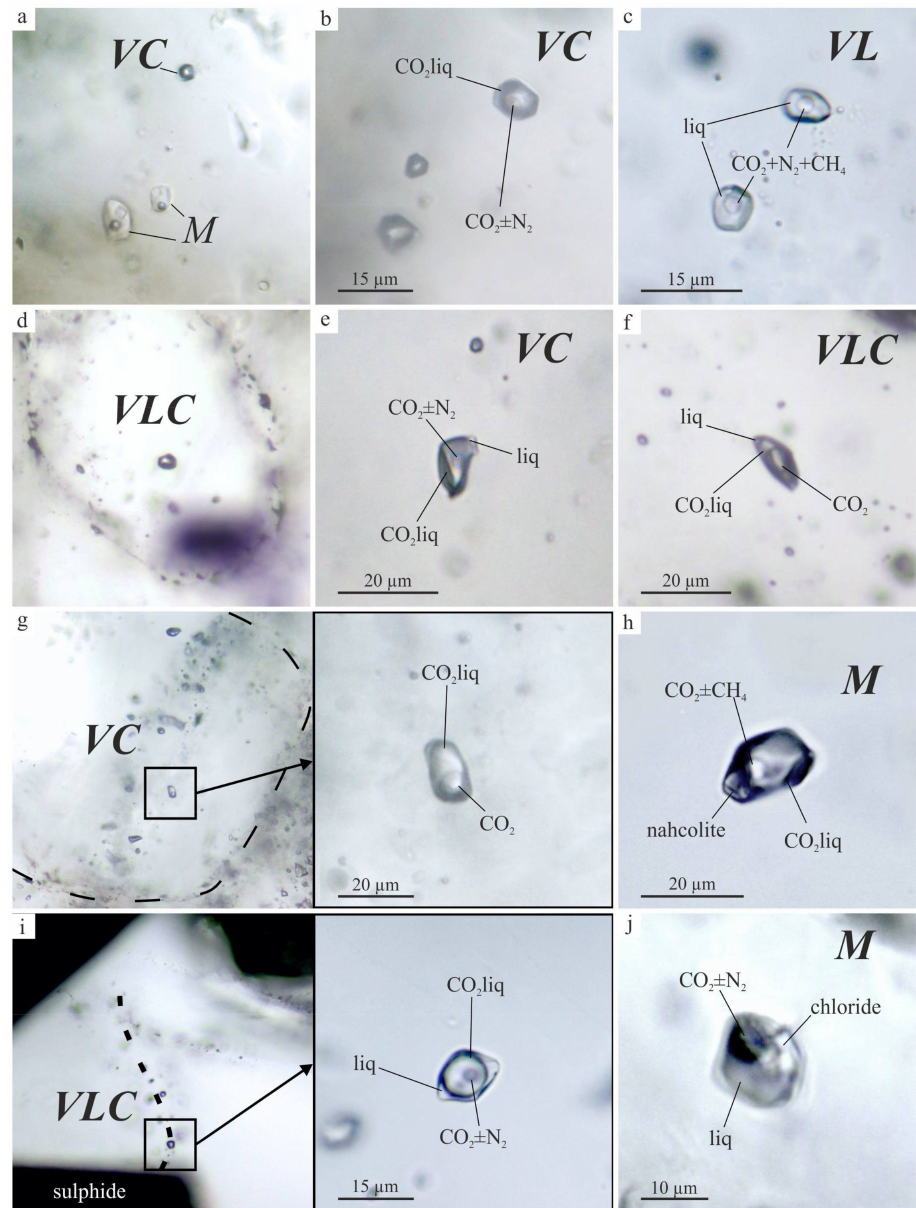
Figure 20. Fluid inclusions in quartz from the Kultuma deposit. ( a – c ) Primary FI in quartz from retrograde skarns; ( d – f ) primary FI in quartz from potassic alteration assemblage (( e ) Kultuma deposit, ( d , f ) Ochunogda region); ( g – j ) FI in quartz from propylitic alteration assemblage: ( g , h ) primary; ( i , j )